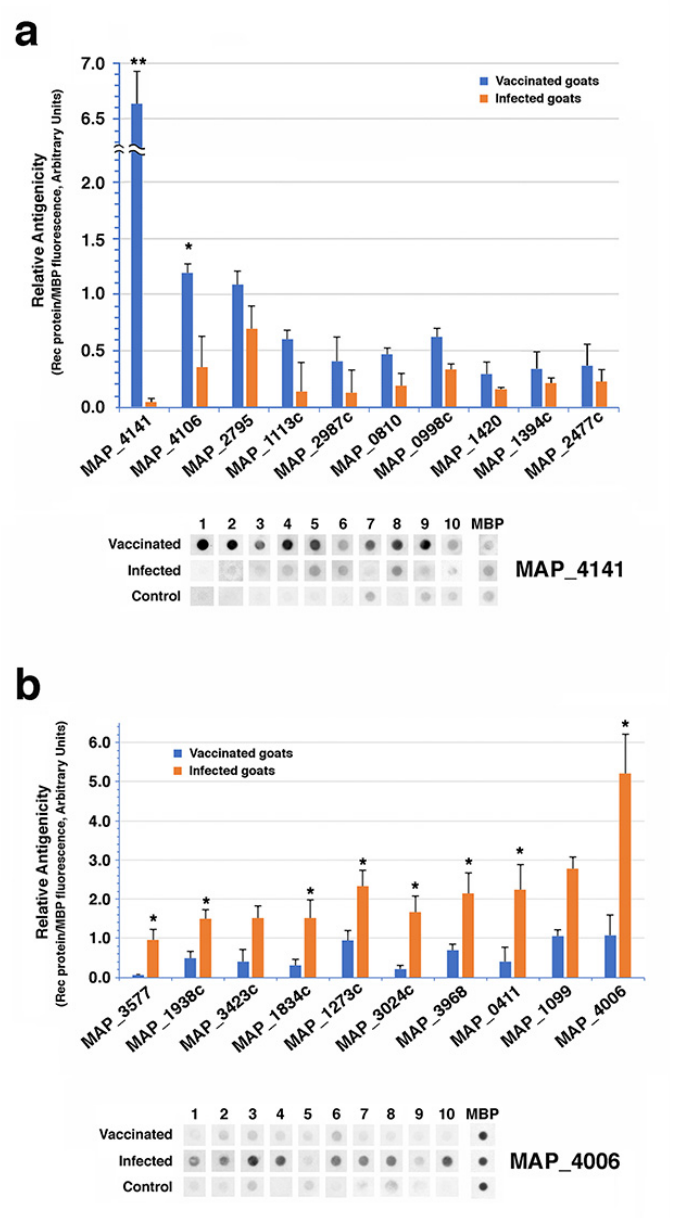
Figure 7. Antibody profiling of infected and vaccinated goats using 190 recombinant proteins. ( a ) The ten most differentially reactive recombinant proteins in the vaccinated group. Note the y -axis scale break for MAP_4141. ( b ) Ten most differentially reactive proteins in the infected group. Error bars represent standard error of the means. Asterisks denote significance between treatments (* = p < 0.05; ** = p < 0.01). Beneath each bar graph is the dot blots of all 30 goats for the strongest antigen in that treatment group. The MBP spots indicate amount of recombinant protein spotted. library screen was MAP_3185, a PPE family protein. This protein was detected by the vac- cine only goats in the library screen (Table 2) and dot blot analysis confirms stronger re- activity to the vaccinated goats compared to infected goats (Supplemental Table S2).